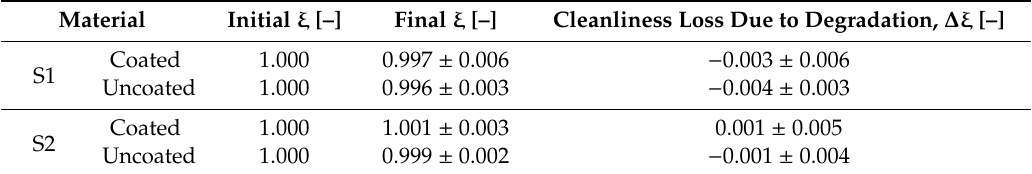
Table 1. Reflectance measurements performed in the laboratory before and after exposure together with the reflectance loss.